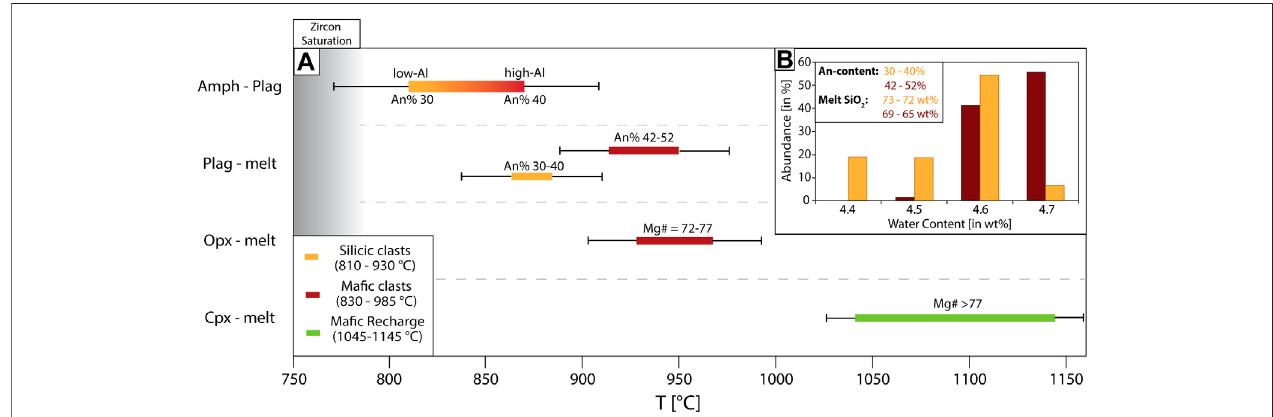
FIGURE 8 | Pre-eruptive temperatures (A) and water contents (B) for three different Aso equilibrium assemblages. Orange colors display mineral assemblages in equilibrium with (rhyo-)dacitic melt, red colors indicate equilibrium with dacitic melt present in the cumulate mush and green stands for assemblages in equilibrium with ma fi c recharge melt. Temperatures were calculated applying different thermometers. The length of the bars indicate the range of temperatures obtained by each thermometer, black extensionsshow the range oferrors. The Amph-Plag thermometeris theplagioclase-amphibole thermometer (Holland and Blundy,1994) and the Plag-melt, Opx-melt and Cpx-melt thermometers stand for plagioclase- and pyroxene-melt thermometers from Putirka (2016, 2008). Summarized temperature rangesforeachequilibriumassemblagearegiveninthelowerleftcorner.Watercontentsin (B) arecalculatedforplagioclasesinequilibriumwith(rhyo-)daciticanddacitic melt, independently, applying the hygrometer from Waters and Lange